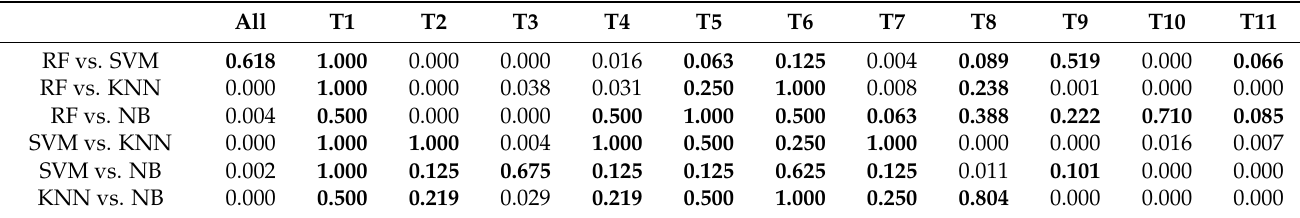
Table 8. McNemar’s test for each of the two classifiers in the object-based method.